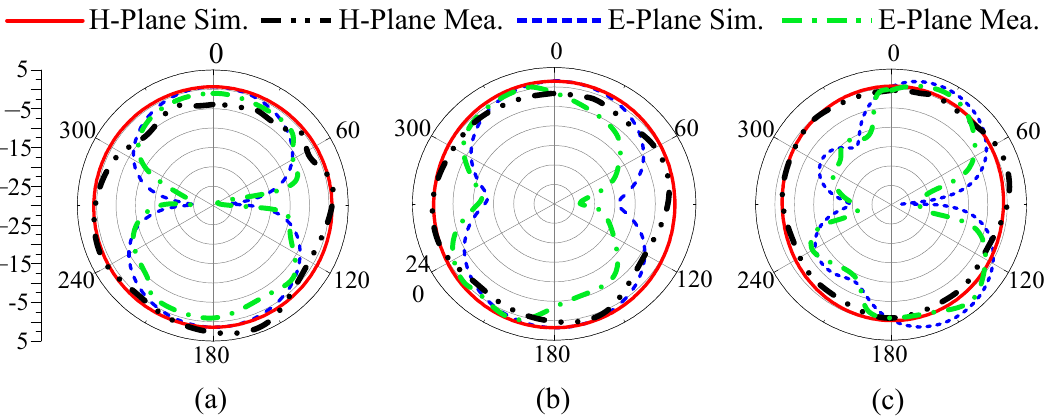
15 Simulated Gain Measured Gain Simulated Efficiency Figure 12. Gain and radiation efficiency of the proposed antenna. 3.5. Comparison with State-of-the-Art Works Table 2 illustrates a performance comparison between the proposed antenna and state-of-the-art antennas dedicated to the same applications. The antenna outperformed the existing antennas with its compact size, wider operating bandwidth, higher gain and stop-band functionality.